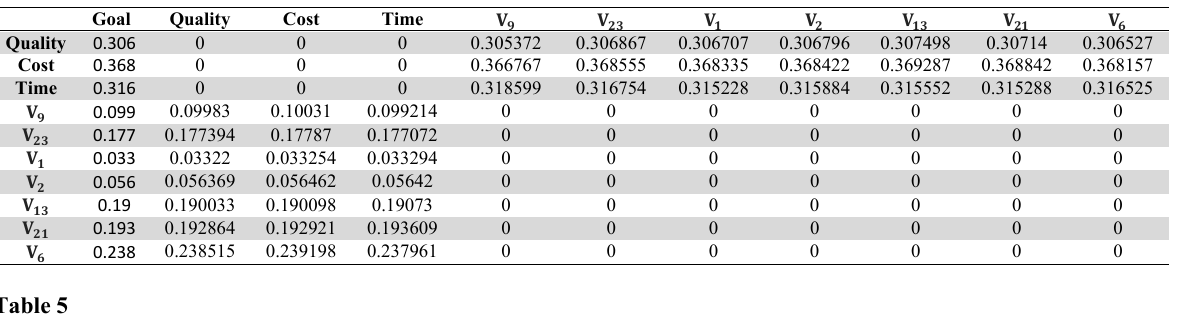
The ultimate weights of the basic criteria